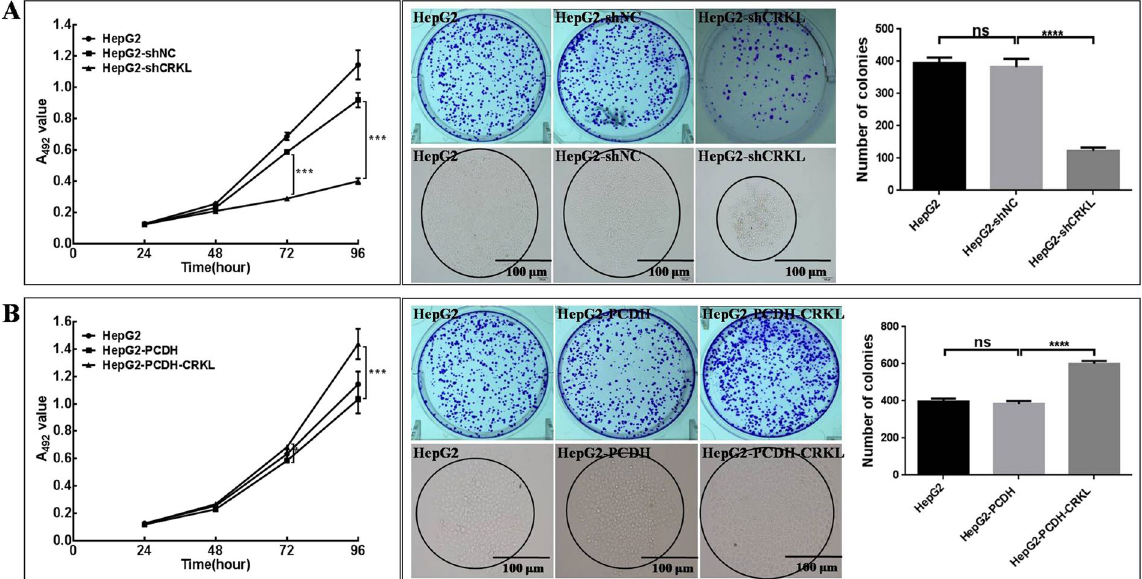
Figure 7. The effect of CRKL level change on HepG2 growth. ( A ) CRKL knockdown decreased the proliferation and colony formation abilities of HepG2 cells. ( B ) CRKL overexpression promoted the proliferation and colony formation ability of HepG2 cells. *** and **** refer to the differences with P < 0.001 and 0.0001, ns refers to no statistical difference,